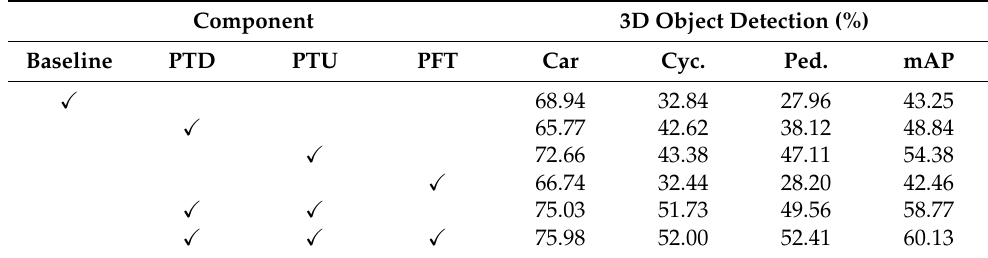
Table 5. Contributions of PTD/PTU/PFT modules to PTA-Det.